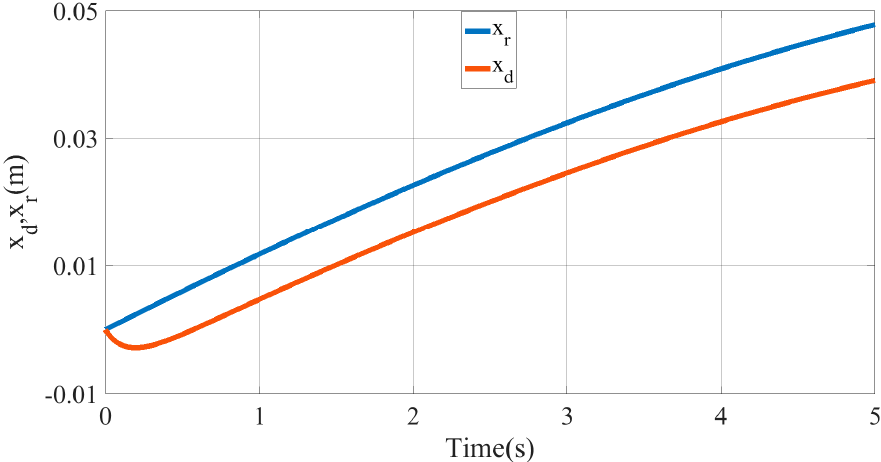
x and the desired trajectory x d